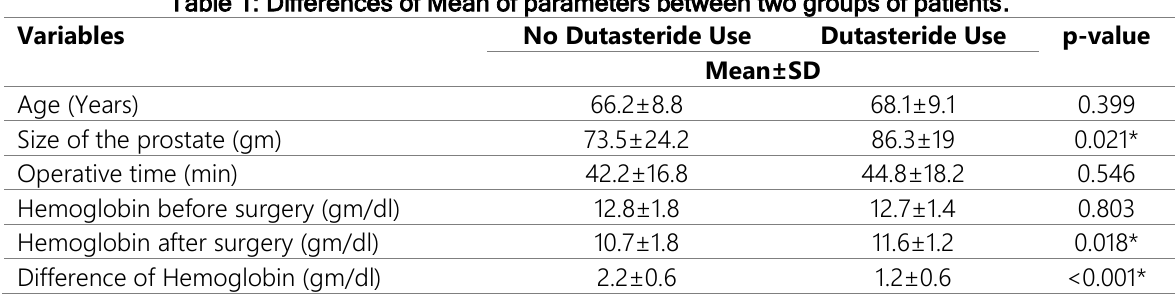
*p-value<0.05 is considered statistically